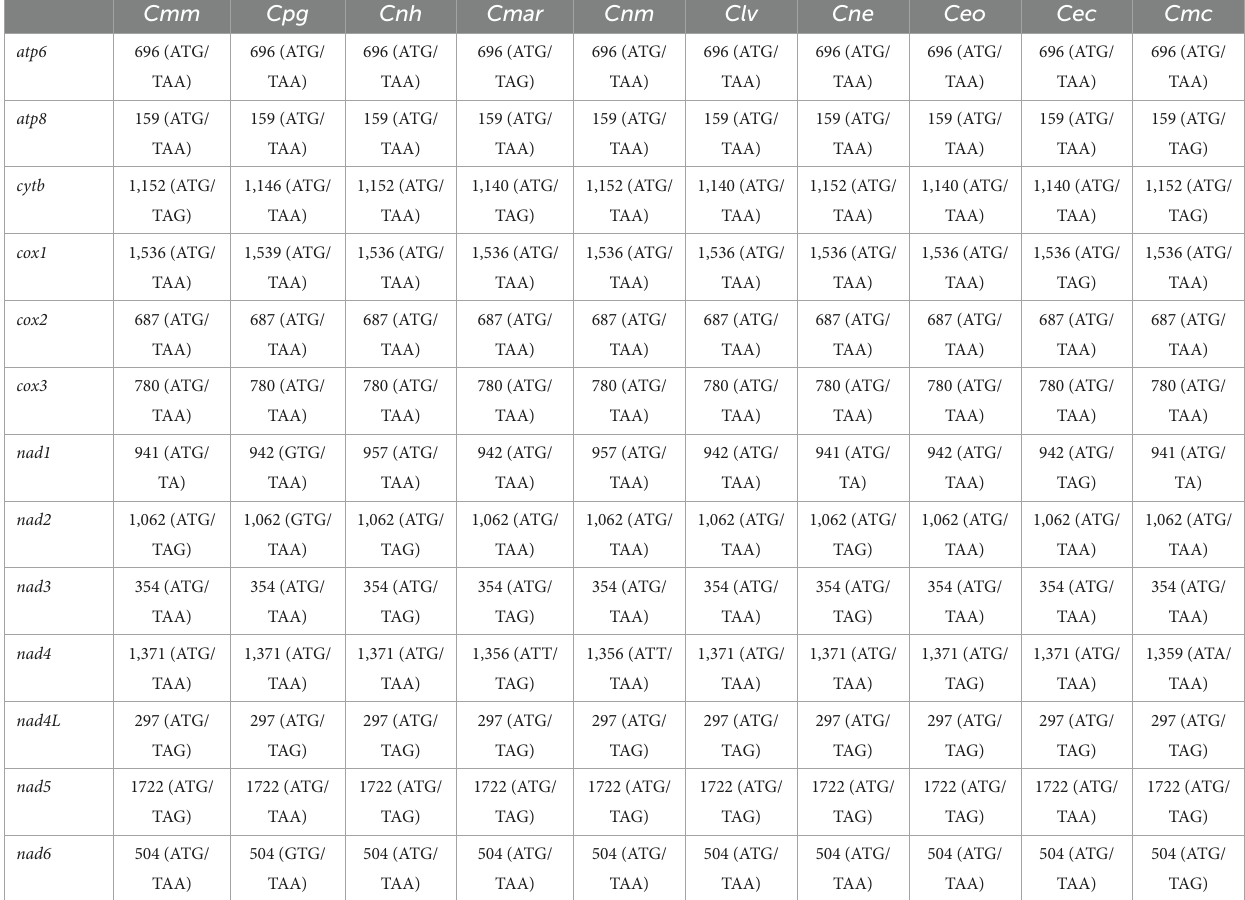
TABLE 3 The length, start and stop codons for mitochondrial genes of M. moneta ( Cmm ), N. helvola ( Cnh ), P. gracilis ( Cpg ), M. arabica ( Cmar ), N. miliaris ( Cnm ), L. vitellus ( Clv ), N. erosa ( Cne ), E. onyx ( Ceo ), E. caurica ( Cec ), and M. caputserpentis ( Cmc ). Cmm